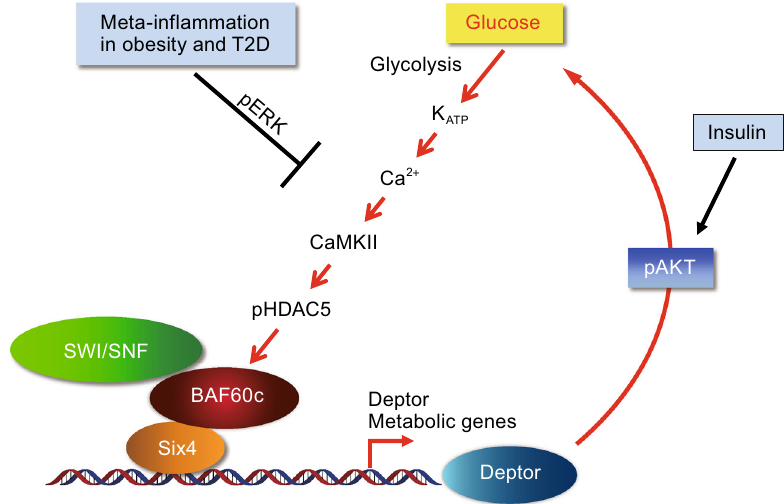
Figure 2. Metabolic regulation by BAF60c in skeletal muscle. BAF60c drives glycolytic muscle metabolism through Deptor- mediated AKTactivation. Mechanistically, BAF60c forms a transcriptional complex with Six4 and recruits the SWI/SNF complex to the proximal Deptor promoter to induce Deptor gene expression. This pathway is important for muscle glucose metabolism and whole body glucose homeostasis in both physiological and diabetic states. In severe diabetic condition, expression of BAF60c and Deptor is downregulated due to activation of ERK pathway by meta-in fl ammation. Rescue of this pathway by either treatment with an ERK inhibitor or transgenic expression of BAF60c in skeletal muscle ameliorates insulin resistance and improves whole body glucose homeostasis in HFD-induced or genetically obese mice. Under physiological condition, BAF60c acts as a glucose sensor in skeletal muscle. Glucose triggers K ATP channel-dependent Ca 2+ response, which elicits the phosphorylation and nuclear exclusion of HDAC5 downstream of CaMKII activation, resulting in BAF60c and Deptor induction and insulin-independent AKT activation. This glucose